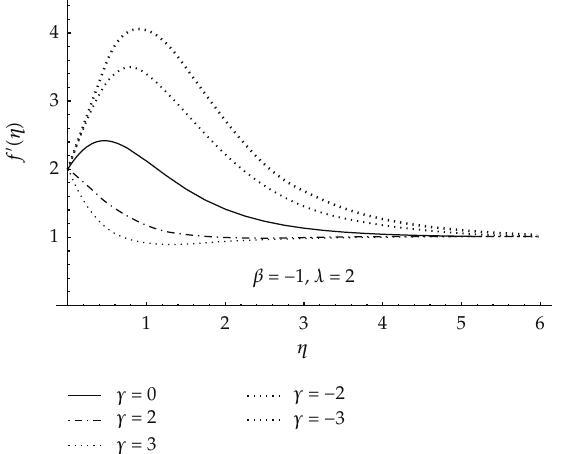
Figure 4: Velocity profiles for suction/injection parameter γ (cid:8) 2 , 0 , − 2 for λ (cid:8) 2.